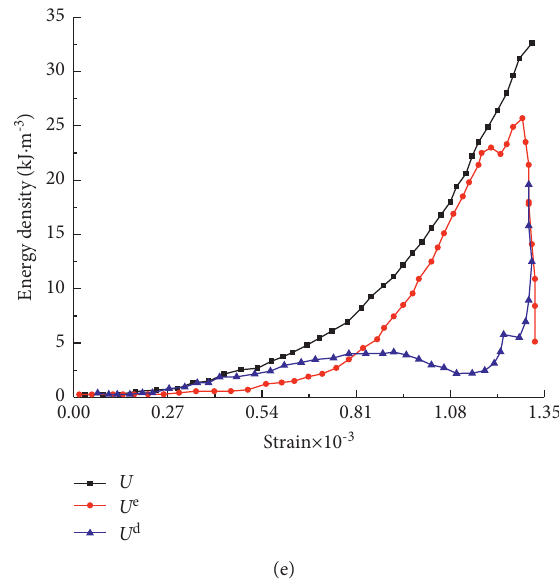
Figure 3: Energy evolution of intact specimens: (a) α � 0 ° ; (b) α � 30 ° ; (c) α � 45 ° ; (d) α � 60 ° ; (e) α � 90 °